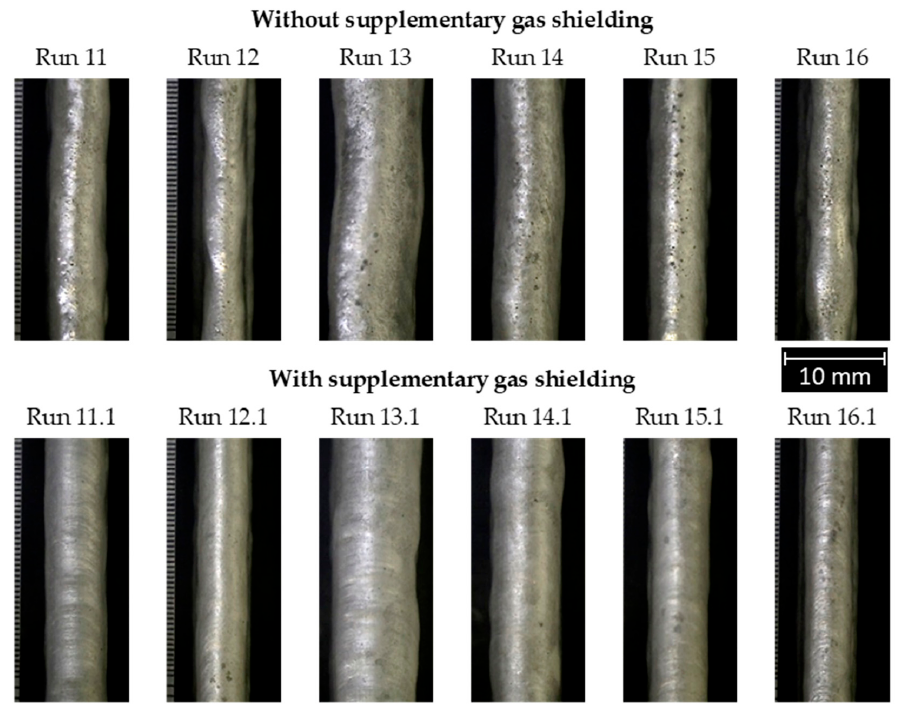
Figure 13. Visual effectiveness of the supplementary shielding gas device.